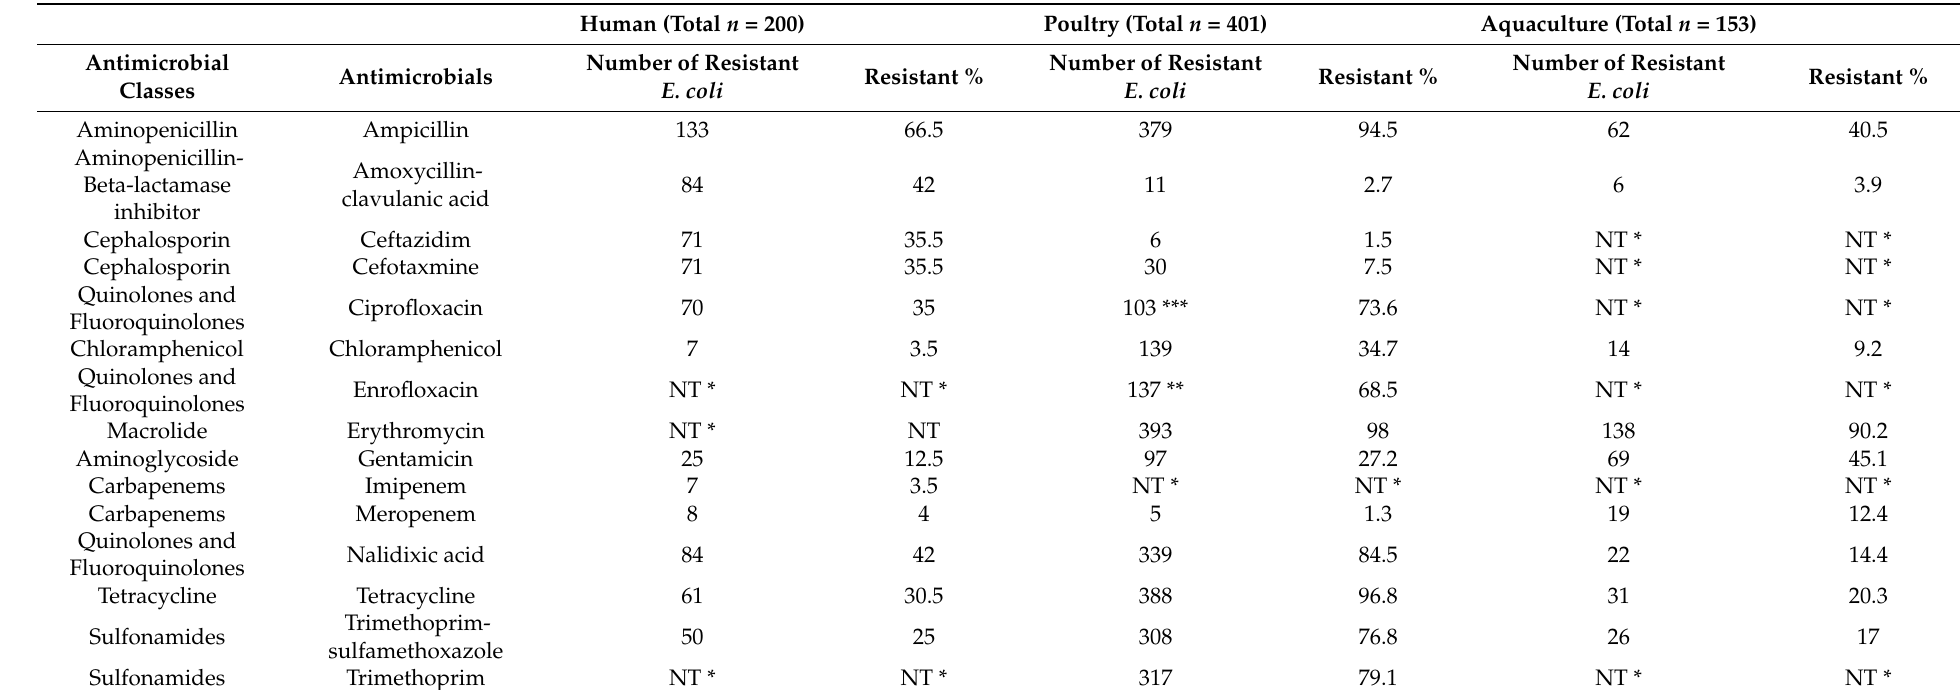
Table 1. Phenotypic antimicrobial resistance in E. coli isolates cultured from samples, collected from humans, poultry, and aquaculture in Paduwasnuwara